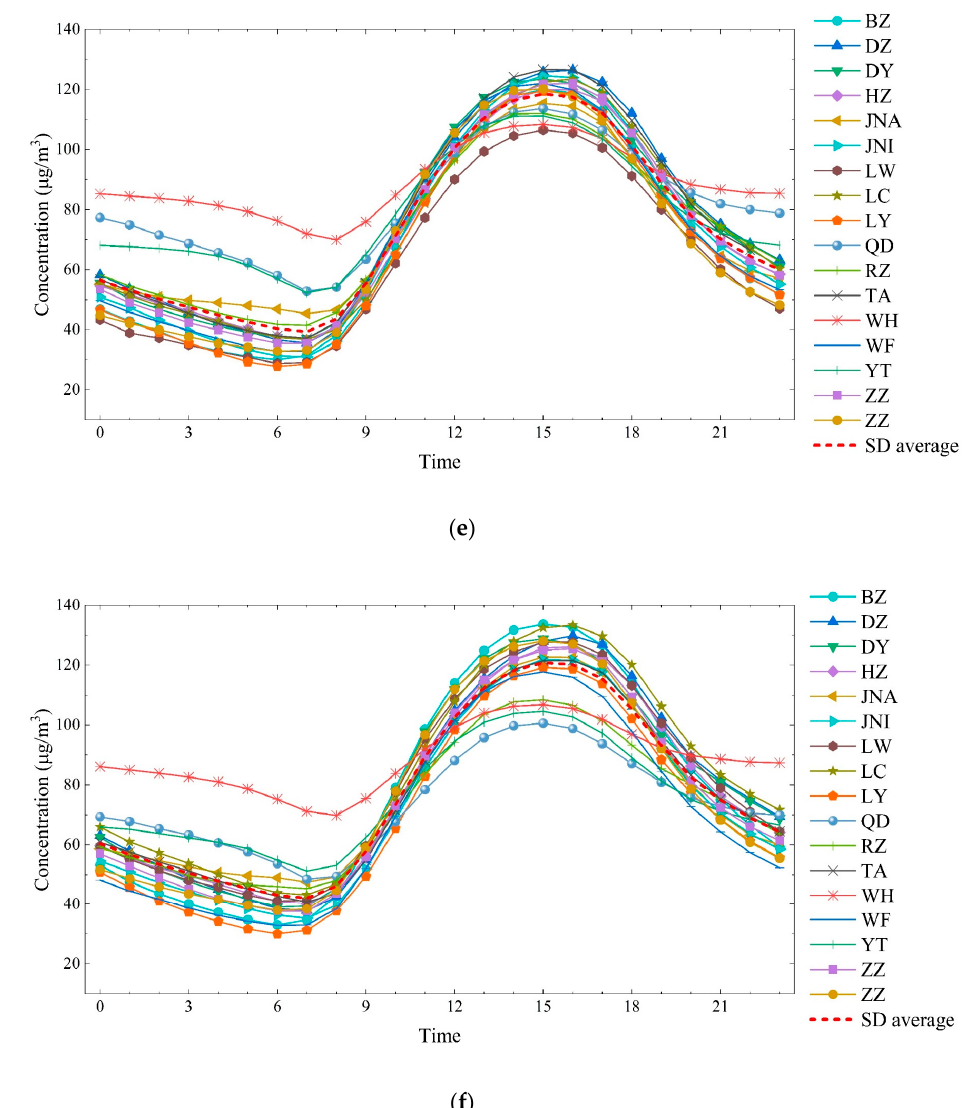
Figure 3. Diurnal variation of ozone concentrations in 17 Prefectural level cities of Shandong province in 2014-2018 (( a ) five years average concentration; ( b ) 2014 average concentration; ( c ) 2015 average concentration; ( d ) 2016 average concentration; ( e ) 2017 average concentration; ( f ) 2018 average concentration).